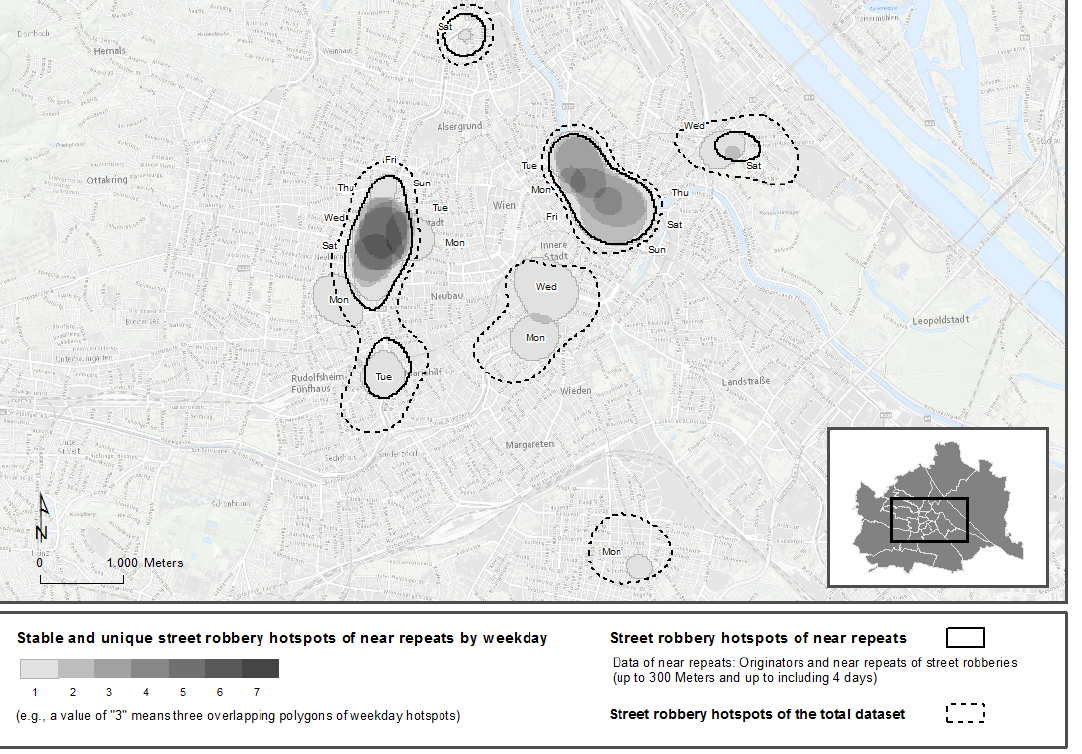
Figure 5. Street robbery hotspots of near-repeats from 10:00 p.m. to 5:59 p.m. by weekday.